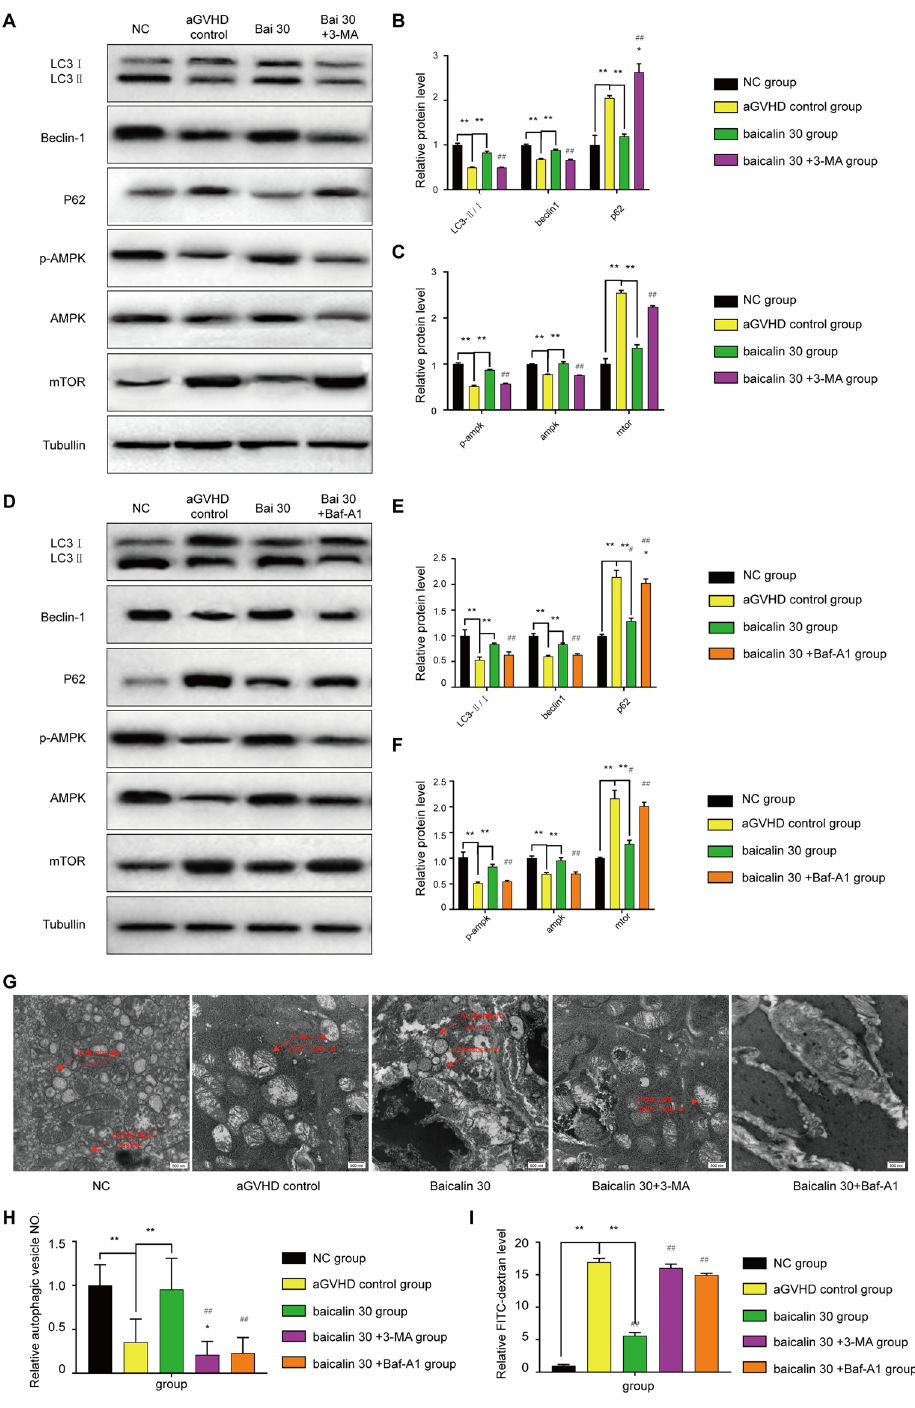
Figure 2. Autophagy level. On the 15th day, samples were collected for testing. ( A ) To confirm that the effect of baicalin is mediated by regulating autophagy, 3-MA was used with baicalin treatment, and the levels of the autophagy-related proteins LC3II/I, Beclin1, P62, p-AMPK, AMPK, and mTOR were measured by Western blotting. ( B ) Analysis of LC3II/I, Beclin1 and P62 protein levels. ( C ): Analysis of the p-AMPK, AMPK, and mTOR levels. ( D ) Measurement of the levels of the autophagy-related proteins LC3II/I, Beclin1, P62, p-AMPK, AMPK, and mTOR by Western blotting after treatment with or without Baf-A1 to inhibit autophagy. ( E ) Analysis of LC3II/I, Beclin1 and P62 protein levels. ( F ) Analysis of the p-AMPK, AMPK, and mTOR levels. ( G ) Autophagic vesicles observed by TEM. ( H ) Analysis of autophagic vesicle numbers in each experimental group. ( I ) Analysis of FITC-dextran levels. All the blots are representative cropped images and every set was processed simultaenously under similar conditions. Representative original blots with cropped demarcations ( A ) are provided in Supplementary Fig. 1. Each experiment was repeated three times.* P < 0.05 and ** P < 0.01 compared with the aGVHD control group. ## P < 0.01 compared with the 30 mg/(kg d) baicilin